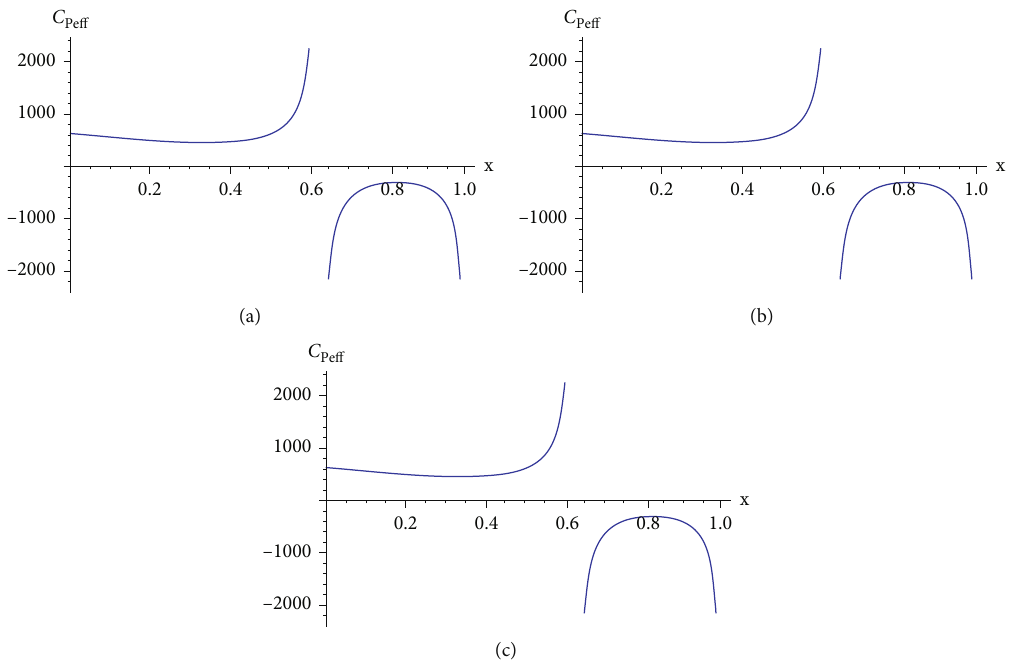
− x curves with l 2 = 100 , and (a) for ϕ 2 pef f